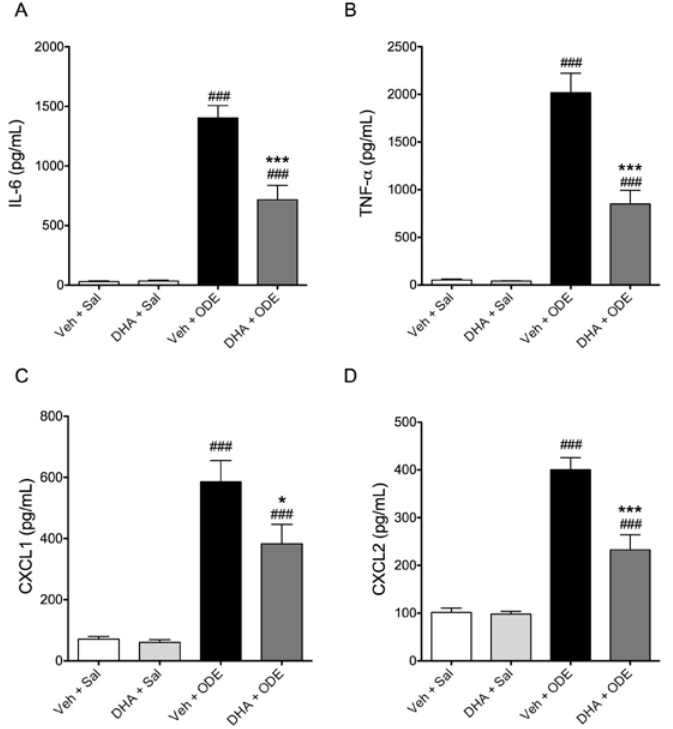
Figure 7. DHA supplementation reduces inflammatory cytokine and chemokine release in mice receiving a single intranasal ODE instillation. C57BL/6 mice were given daily 0 or 2 mg DHA supplementation via oral gavage for seven consecutive days prior to a single intranasal instillation of 50 μL 12.5% ODE or saline. At 5 h following ODE treatment, BALF was obtained and assayed for IL-6 ( A ); TNF-α ( B ); CXCL1 ( C ); and CXCL2 ( D ) via ELISA. ### p ≤ 0.001 vs. vehicle + saline; * p ≤ 0.05 vs. vehicle + ODE; *** p ≤ 0.001 vs. vehicle + ODE. N = 10 mice per group.